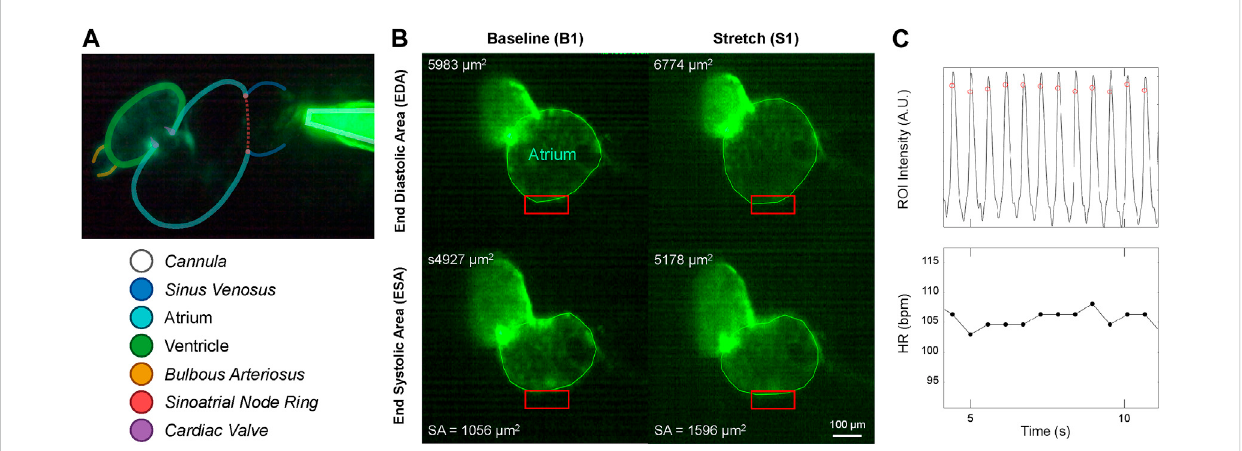
FIGURE 3 Micro-cannula placement and measurement of atrial dilation and functional effects. (A) In vivo image of the 48 hpf zebra fi sh heart expressing eGFP ( Tg(myl7:eGFP ) and the micro-cannula fi lled with fl uorescein, showing the relative position of the cannula to various cardiac regions. (B) Videos of heart during atrial dilation were analysed in Matlab to calculate function parameters at baseline immediately before (B1-B3) and at the end of load application (S1-S3). Atrial end-diastolic (EDA) and end-systolic (ESA) area were measured by tracing the area of the atria at the end of fi lling and the end of ejection, respectively, from which stroke area (SA) was calculated as EDA - ESA. (C) HR was measured from the time between peaks of fi ltered image intensity signals, acquired by averaging intensity within a region of interest placed over the atrial wall (red boxes in B